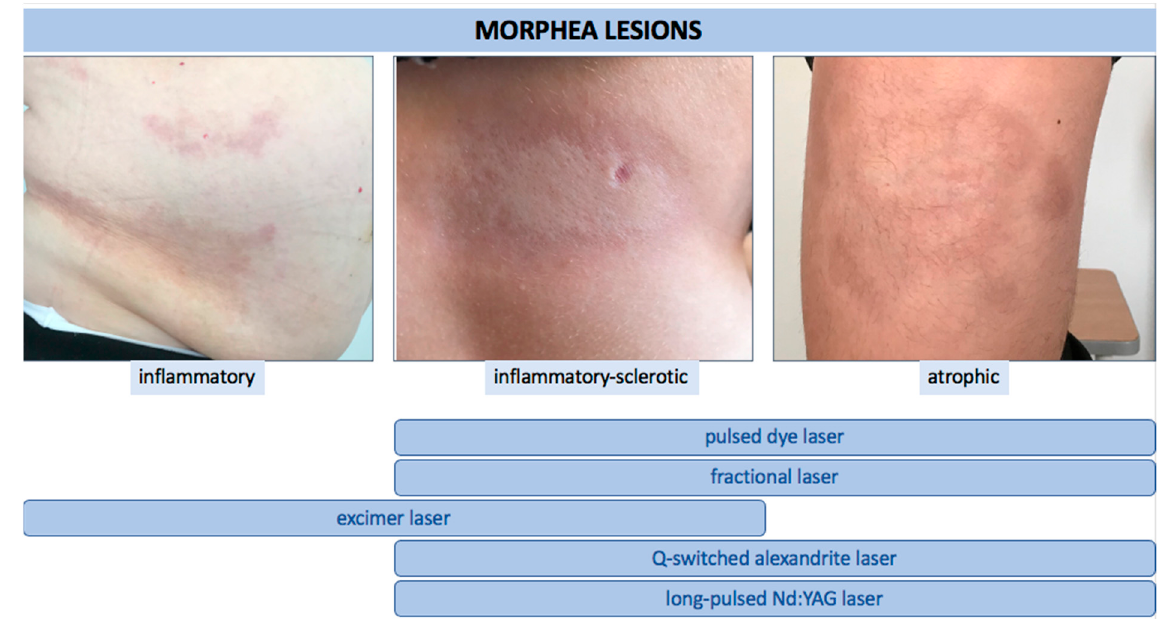
Figure 3. The use of various types of lasers according to clinical stage of LoS. Based on this literature review, laser therapy may be a valuable treatment in some cases of clinically evident LoS lesions or those confirmed by histopathological examination, but it should be kept in mind that this treatment does not slow down the overall course of the disease and does not prevent the formation of new lesions. Therefore, in patients with aggressively progressive lesions, general treatment should be introduced, while laser therapy may be considered as an adjuvant method to treat cutaneous complications of LoS or for cosmetic reasons to provide a better quality of life for the patients. A short recovery time that allows an early return of patients to daily activities, and a single session that enables complete or at least partial remission sustained over a long period of time, certainly form the basis for better patient compliance compared to the systematic use of topical medications [76]. Moreover, in some cases, laser application enables the abandonment of systemic treatment, which may be associated with the occurrence of complications and often requires periodic check-ups. Thus, the effectiveness and safety of laser application should encourage the pursuit of controlled studies with a greater number of patients to better determine its role in the treatment of LoS.